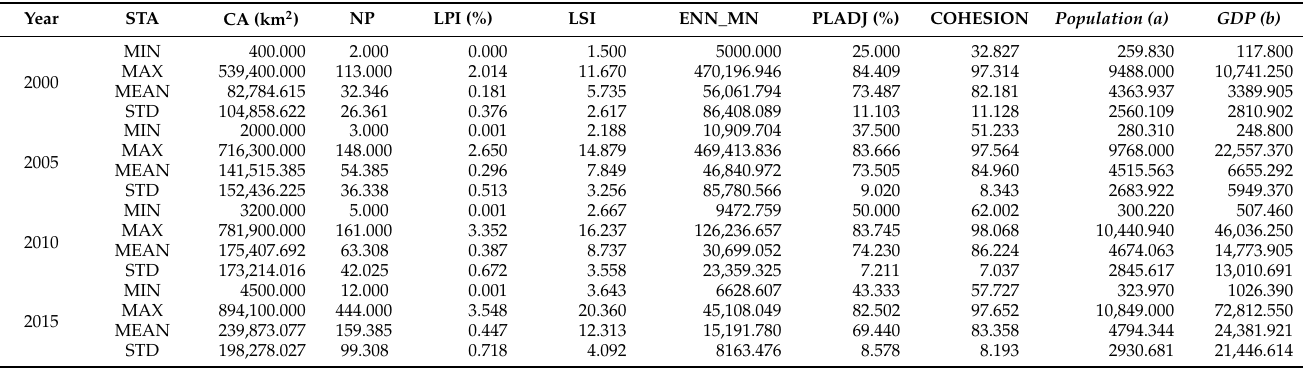
Table 1. Statistics of the metrics at the provincial scale.